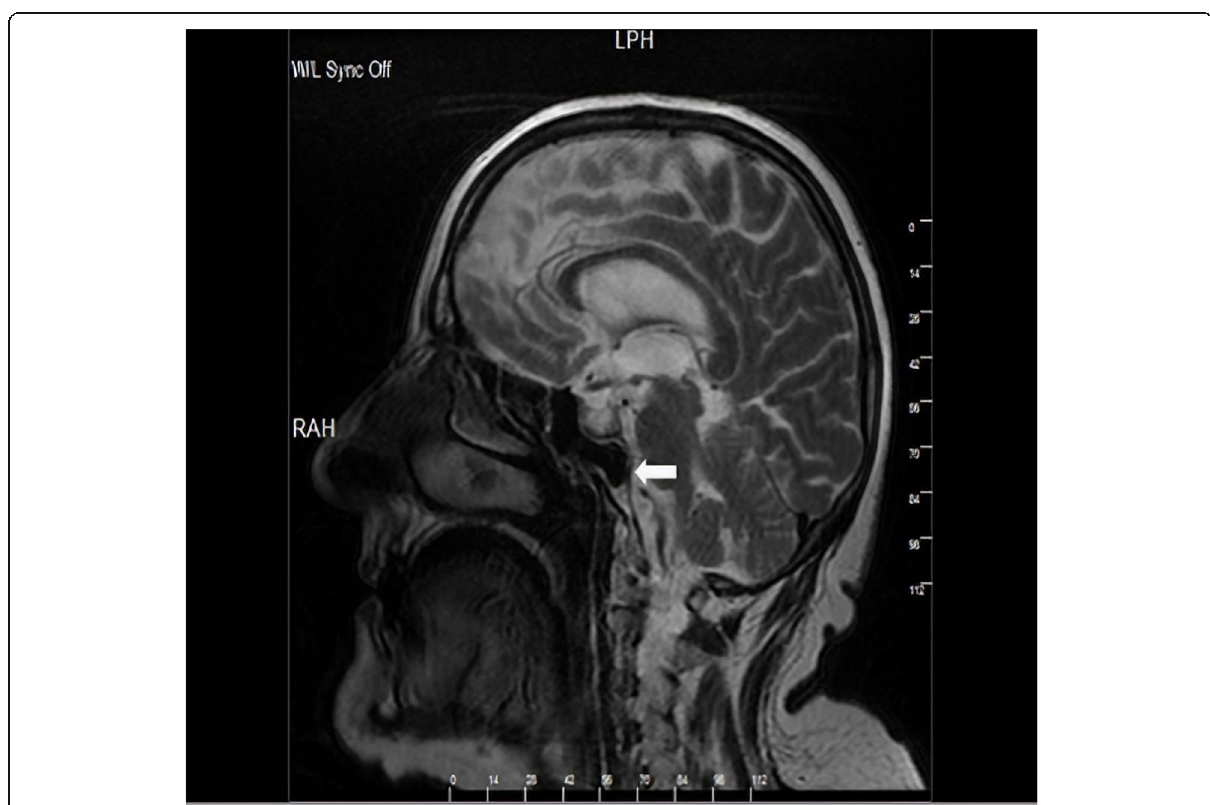
Fig. 2 Sagittal T2-weighted magnetic resonance image shows excessive pneumatization of the clivus (arrow)